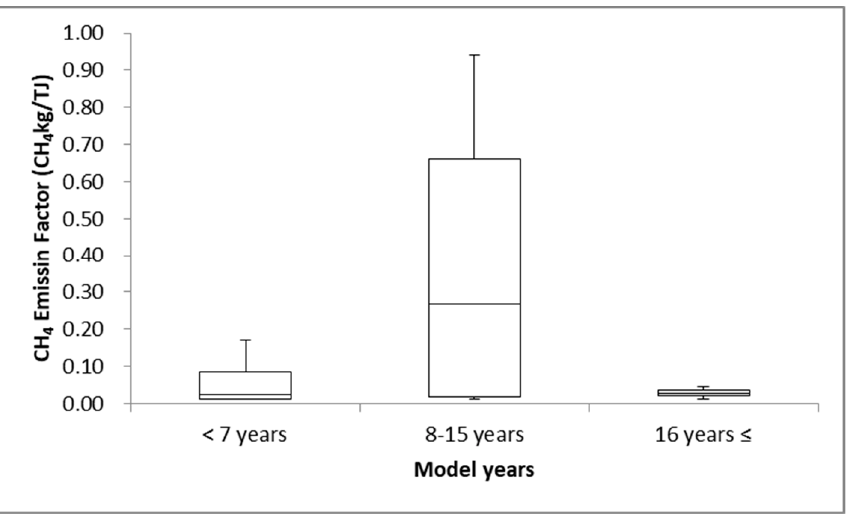
Figure 4. Box plot of developed CH 4 emission factor of boilers model year